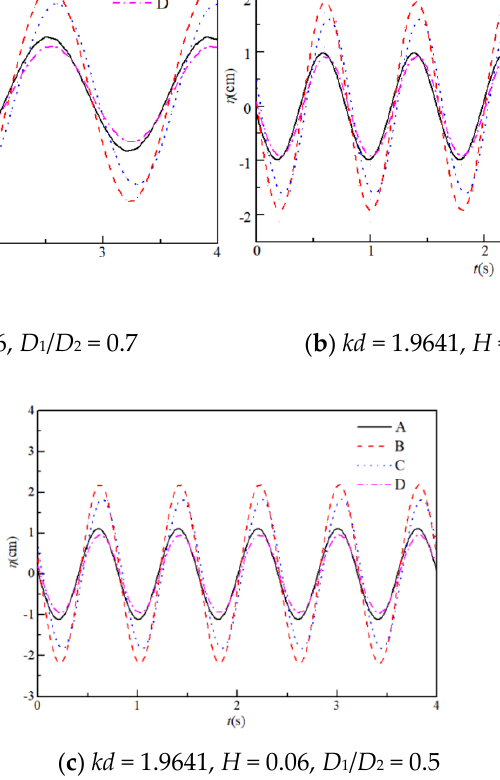
Figure 7. Time series of wave free-surface elevation at four positions in the chamber at ( a ) C 1 , ( b ) C 2 , and ( c ) C 3 conditions.